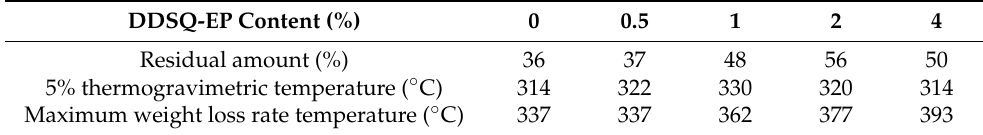
Table 1. TGA results of PBZ/DDSQ-EP materials in different DDSQ-EP contents.